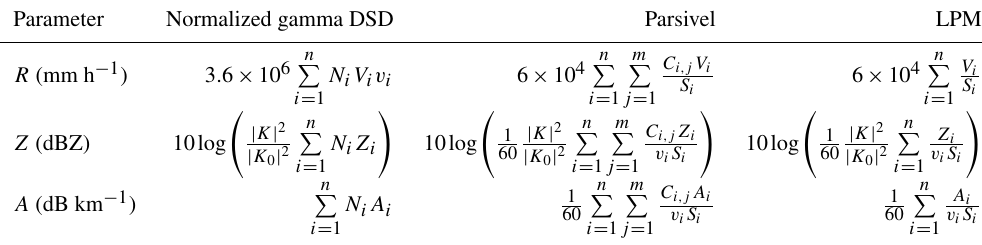
Table A5. Summary of calculation formulas for rain rate, reflectivity, and attenuation for the normalized gamma DSD, DSD from Parsivel, and drops detected by LPM. For the normalized gamma DSD and Parsivel, the index i ranges over n diameter bins, while for LPM it varies over n drops detected by the instrument 1min prior to a radar sample time. The index j moves over m velocity bins of Parsivel. C i,j is the cell of the Parsivel raw data matrix. N i is a number of particles in the diameter bin i . V i and v i are volume in cubic meters and terminal velocity in meters per second of a drop with the diameter D i , respectively. Z i and A i are reflectivity and attenuation for one drop, with the diameter D i in a unit volume, respectively. S i = L b (W b − D i / 2 ) is the effective sampling area in square meters of a disdrometer, with L b and W b being the length and the width of the disdrometer laser beam (Tokay et al., 2014). | K | 2 is the dielectric factor of water at a certain temperature. | K 0 | 2 = 0 . 74 is the constant dielectric factor of water at 8 ◦ C set in the processing routine of the used